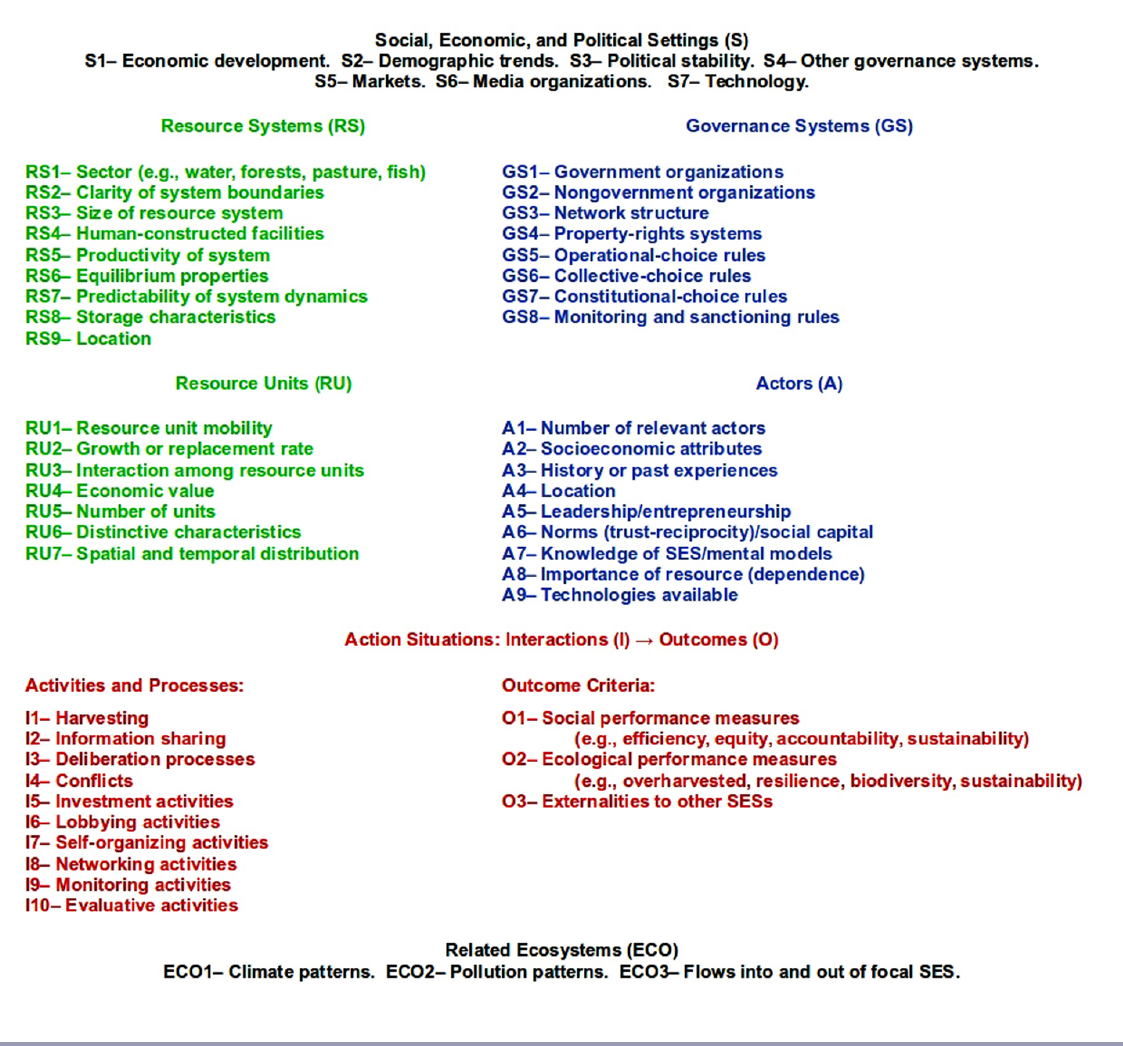
Fig. 1. The first-tier and second-tier concepts of the Ostrom (2009) social-ecological system framework, including minor refinements made by McGinnis and Ostrom